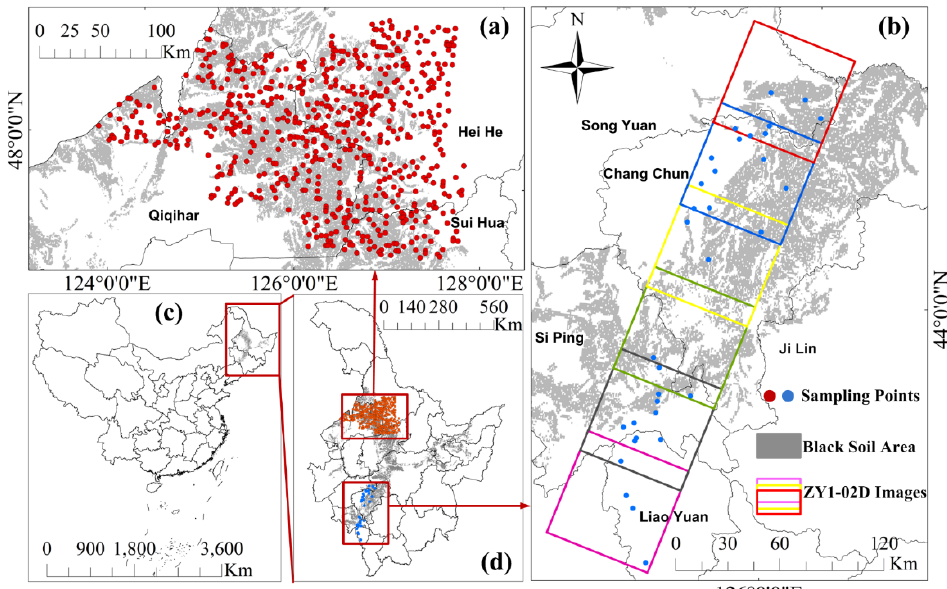
Figure 1. The geographic extent of the study area: ( c , d ) indicate the location of main typical black soil area in northeast China and sampling points. Red points in ( a ) indicate the position of sampling points that would be applied in lab spectral analysis for soil N content sensitive spectral bands detection, blue points in ( b ) indicate sampling points located at the ZY1-02D images covered area, which would be applied in cross-region validation and soil N content estimation modelling. Correspondingly, a neat line of six ZY1-02D images is shown in ( b ).